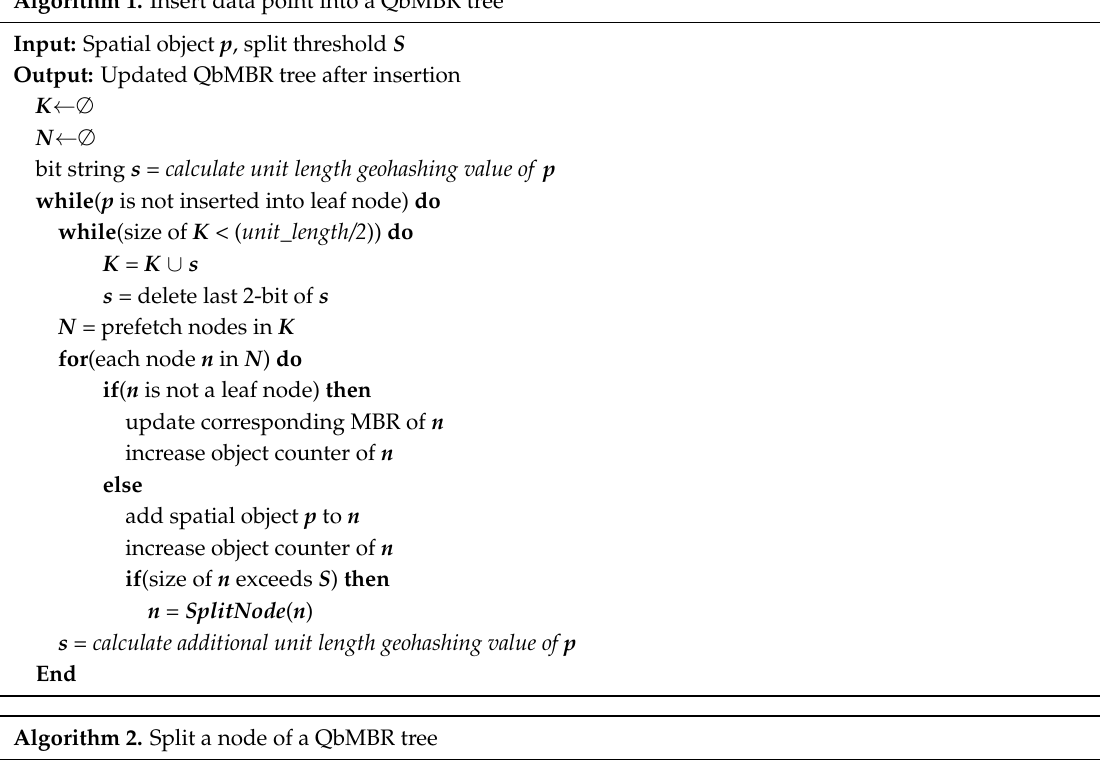
Algorithm 1. Insert data point into a QbMBR tree